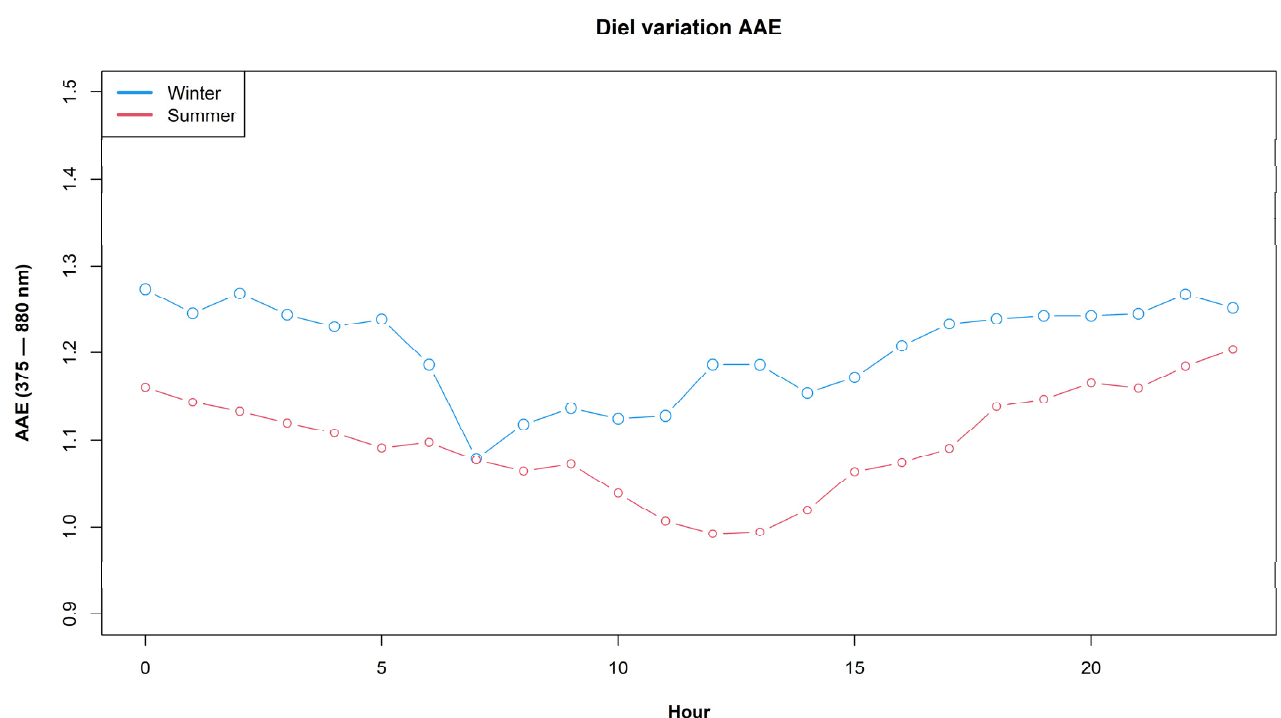
Figure 2. Diel profiles of AAE for (austral) summer and winter months.